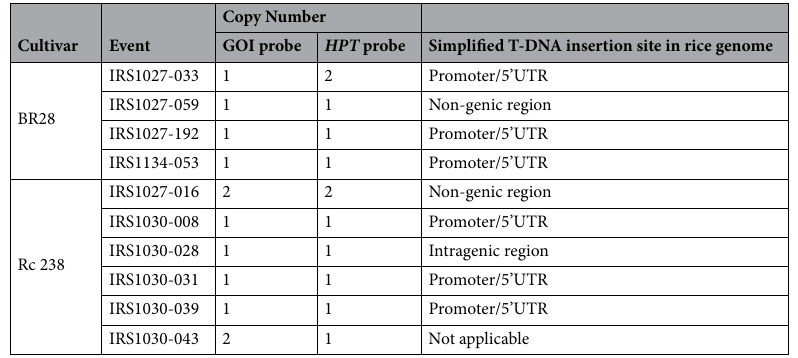
Table 2. DNA blot characterization overview of the selected events and simplified information for the T-DNA insertion